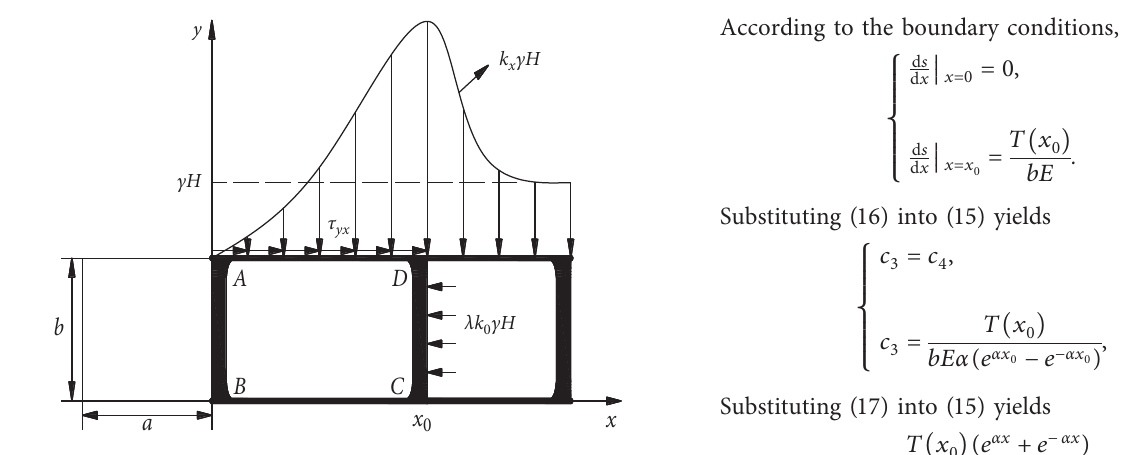
Figure 2: Simplified mechanical model of rib coal-body.